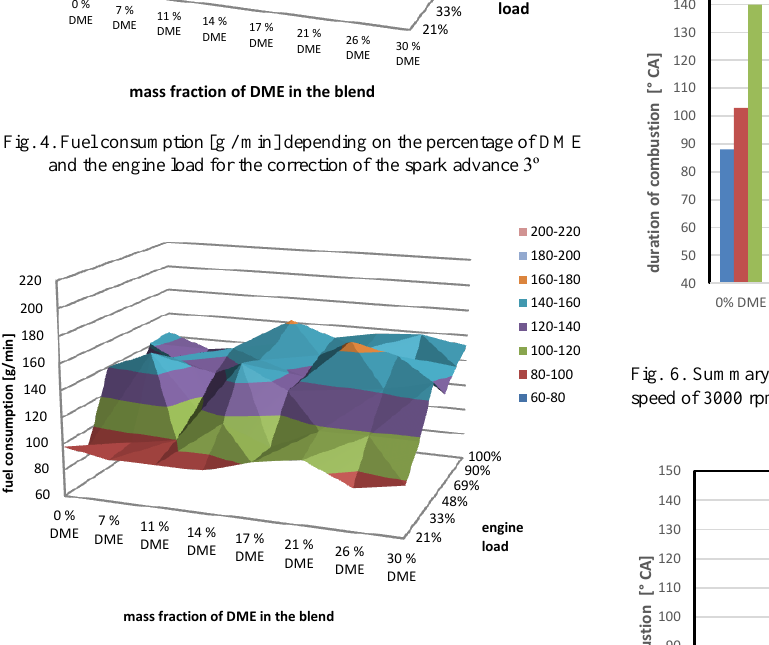
Fig. 5. Fuel consumption [g/min] depending on the percentage of DME and the engine load for the correction of the spark advance 6º